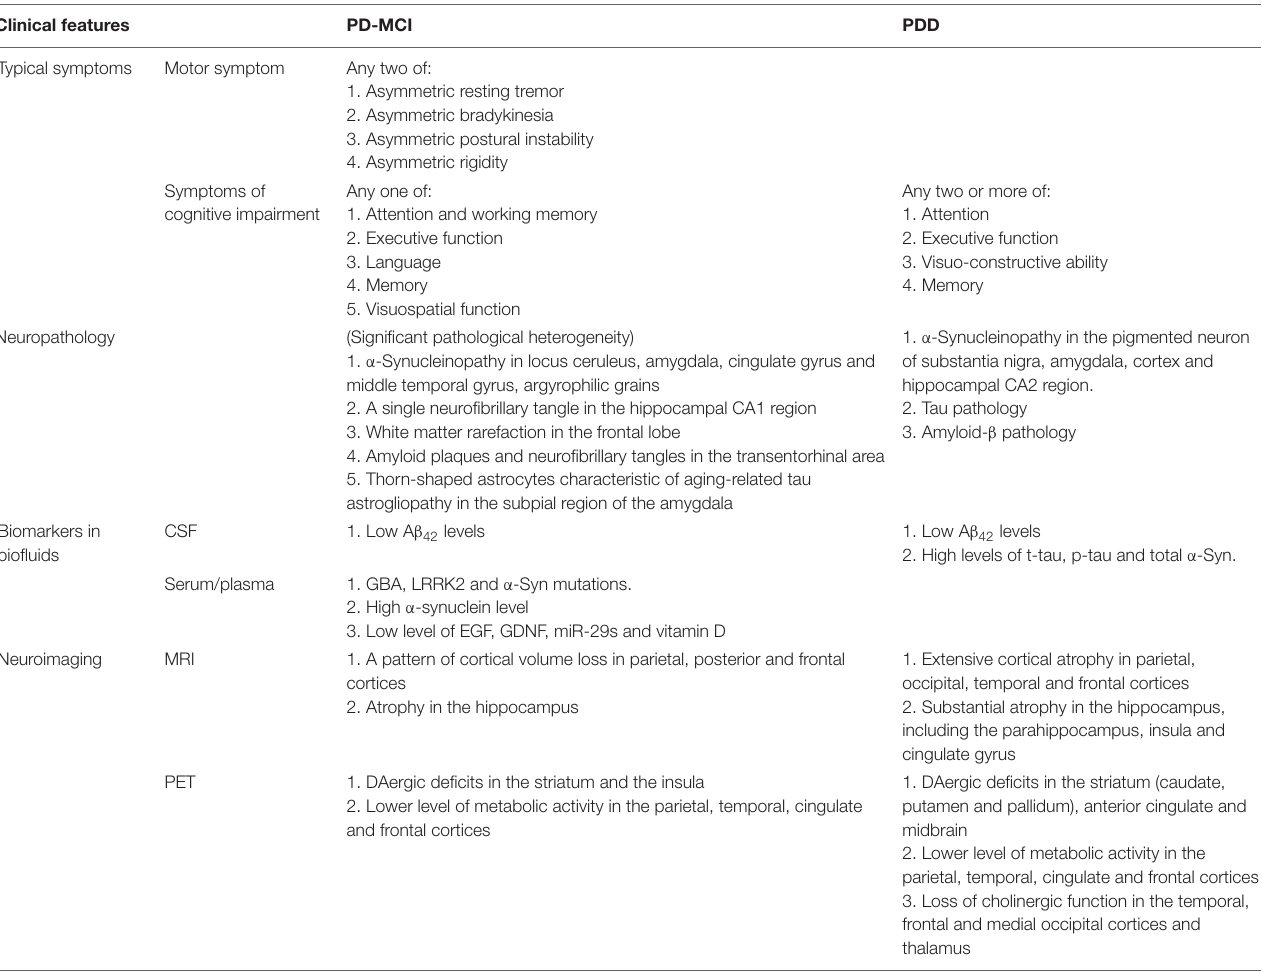
TABLE 1 | The clinical features of PD-MCI and